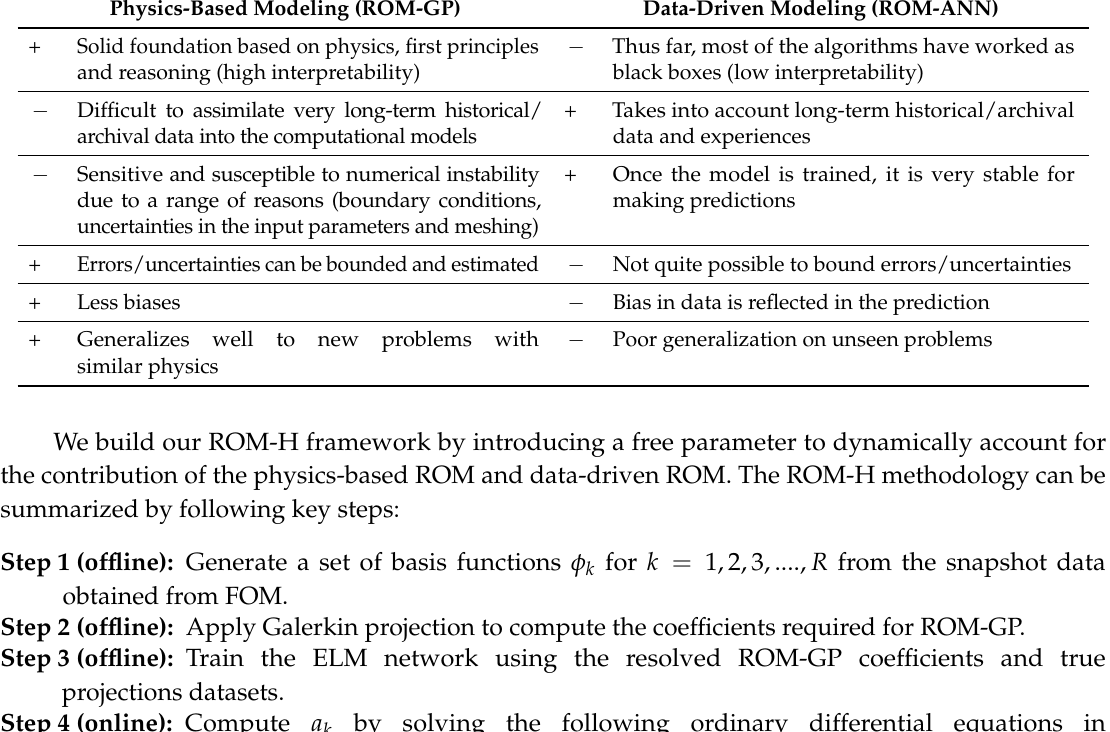
Table 2. Physics-based ROM vs. data-driven ROM. Physics-Based Modeling